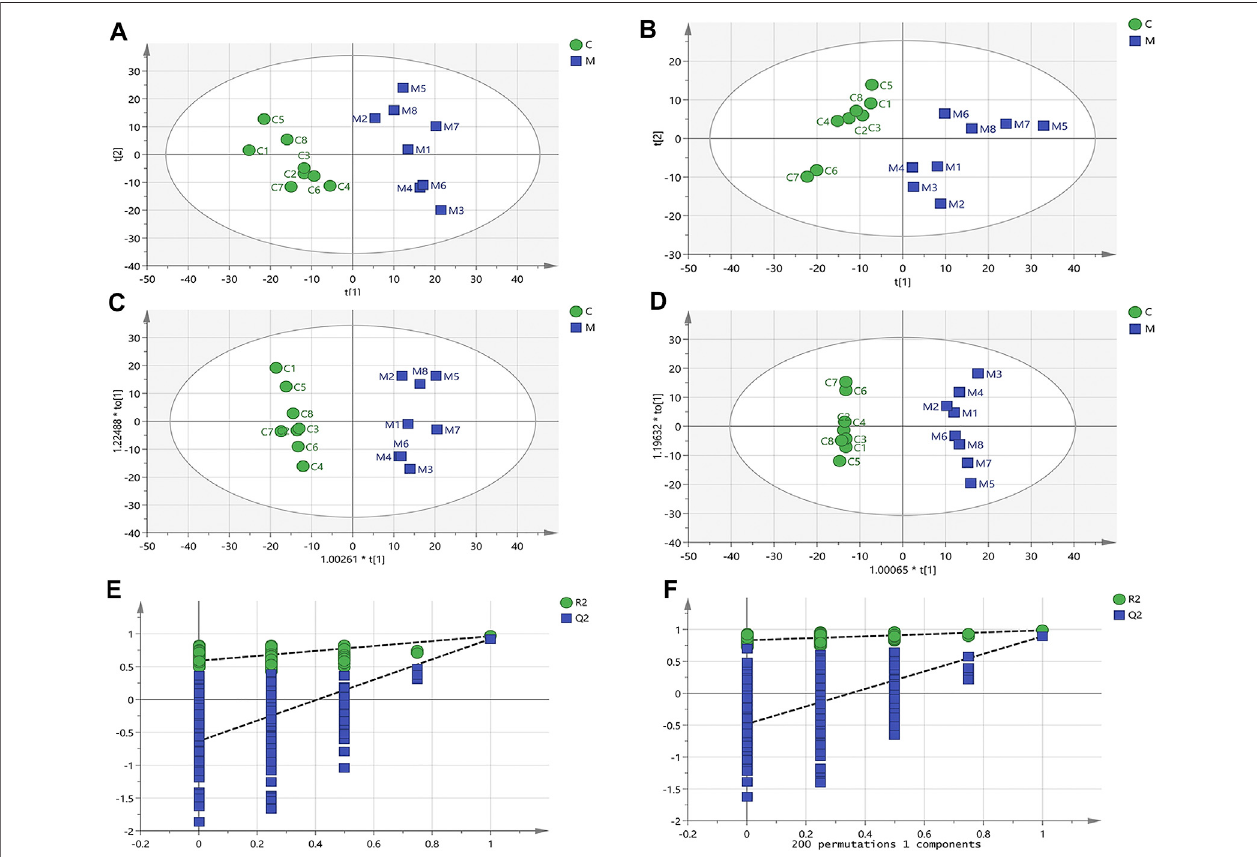
FIGURE 6 | Multivariate data analysis of skin lipidomics. (A) The principal component analysis (PCA) score plots from the skin lipid pro fi les of the C and M experimental groups in positive ion mode (R 2 X (cid:1) 0.746, Q2 (cid:1) 0.531). (B) The PCA score plots from the skin lipid pro fi les of the C and M experimental groups in negative ion mode (R 2 X (cid:1) 0.606, Q2 (cid:1) 0.405). (C) The orthogonal partial least-squares discrimination analysis (OPLS-DA) score plots from the skin lipid pro fi les of the C and M experimental groups in positive ion mode (R 2 X (cid:1) 0.609, R 2 Y (cid:1) 0.964, Q2 (cid:1) 0.924). (D) The OPLS-DA score plots from the skin lipid pro fi les of the C and M experimentalgroupsinnegativeionmode(R 2 X (cid:1) 0.670,R 2 Y (cid:1) 0.986,Q2 (cid:1) 0.895). (E) PermutationtestofthelipidspeciesfromtheOPLS-DAmodelinpositiveionmode (R 2 (cid:1) 0.576, Q2 (cid:1) − 0.623). (F) Permutation test of the lipid species from the OPLS-DA model in negative ion mode (R 2 (cid:1) 0.834, Q2 (cid:1) −